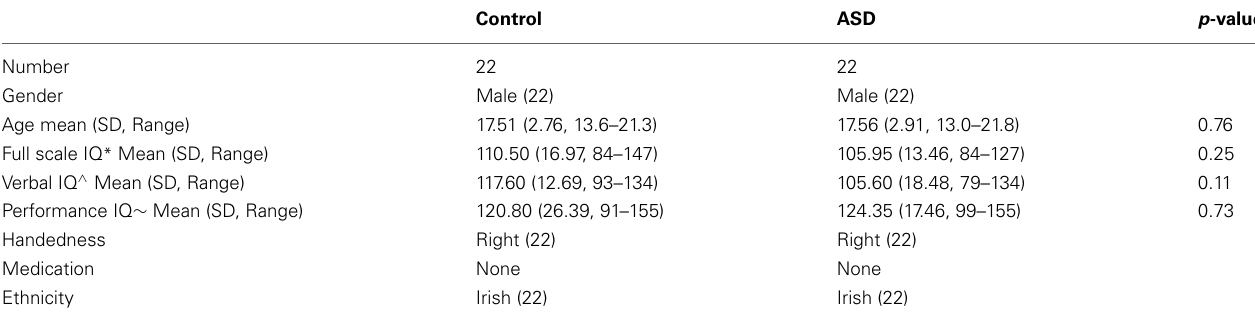
Table 1 | Demographics of study participants *Full scale IQ was estimated based on four sub-scales of the WISC/WAIS [Wechsler Intelligence Scale for Children (WISC-III or IV UK), (Wechsler, 2004) and Wechsler Adult Intelligence Scale (WAIS-III), (Wechsler,